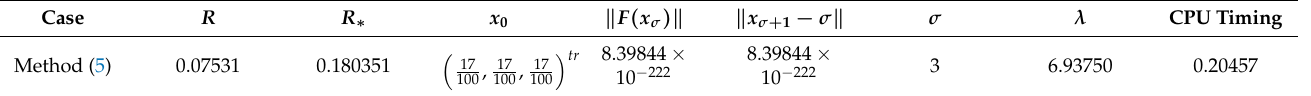
Table 1. Numerical results of Example